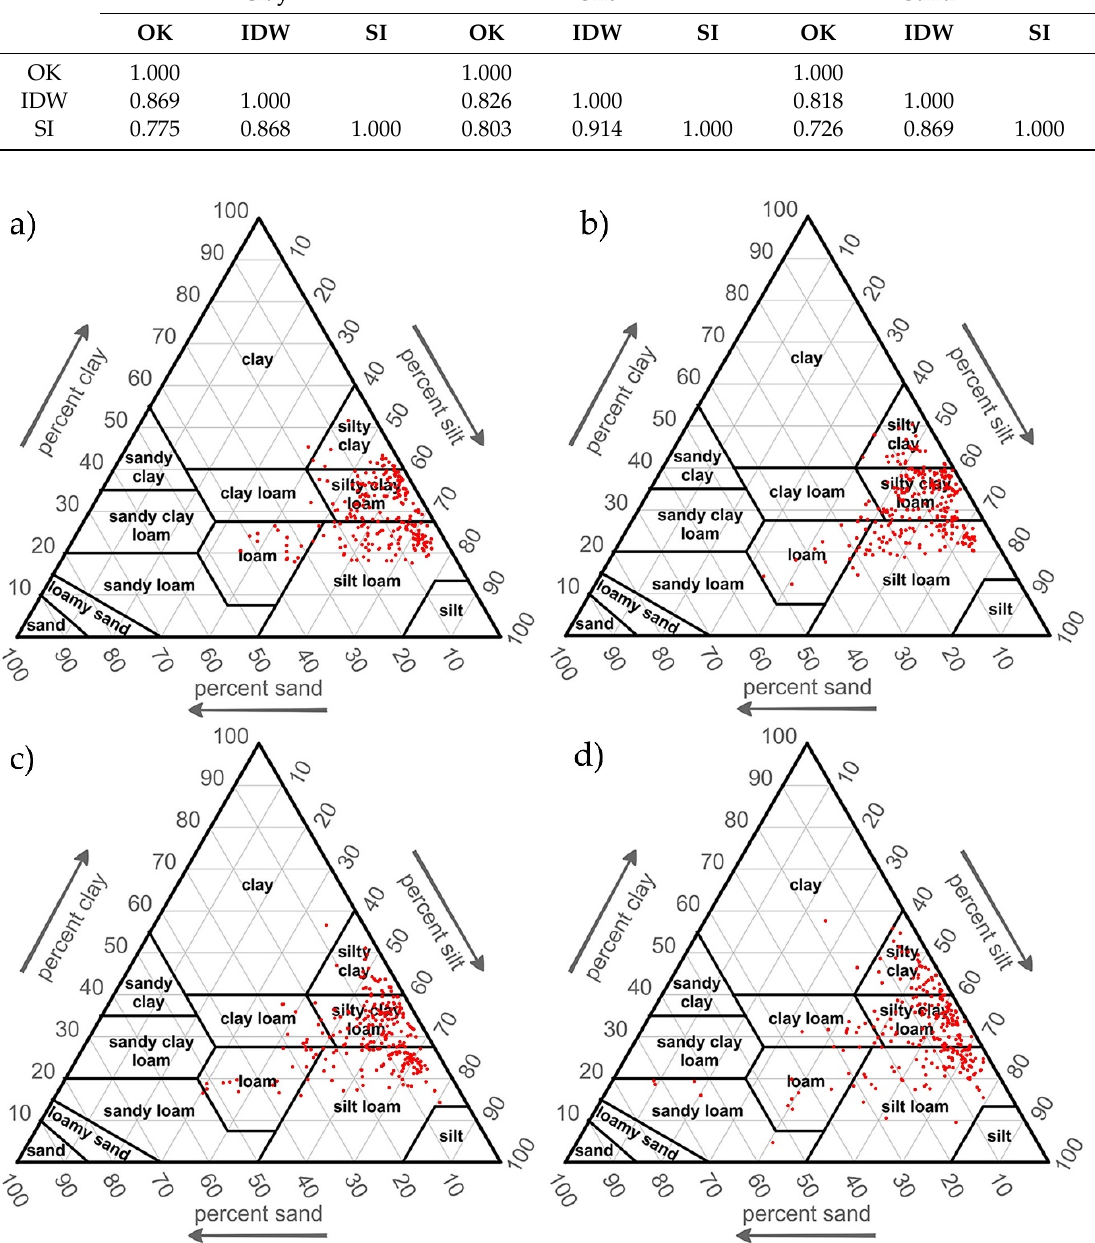
Figure 9. Soil texture triangles classified from: ( a ) ground truth data, ( b ) OK interpolation, ( c ) IDW interpolation, ( d ) SI interpolation.